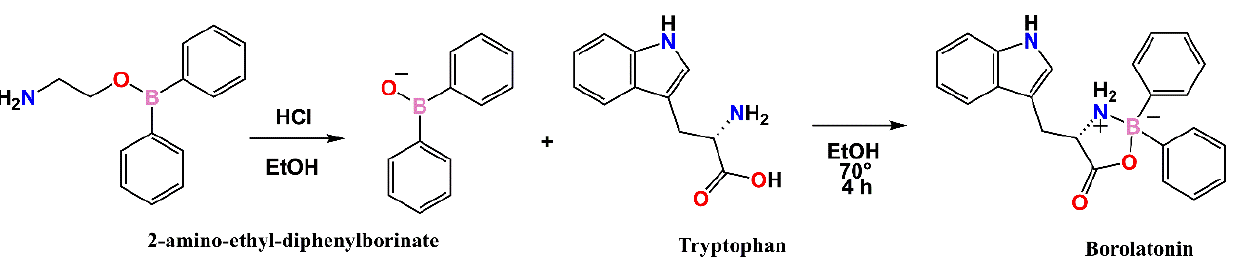
Figure 2. Synthesis procedure of the borolatonin compound.